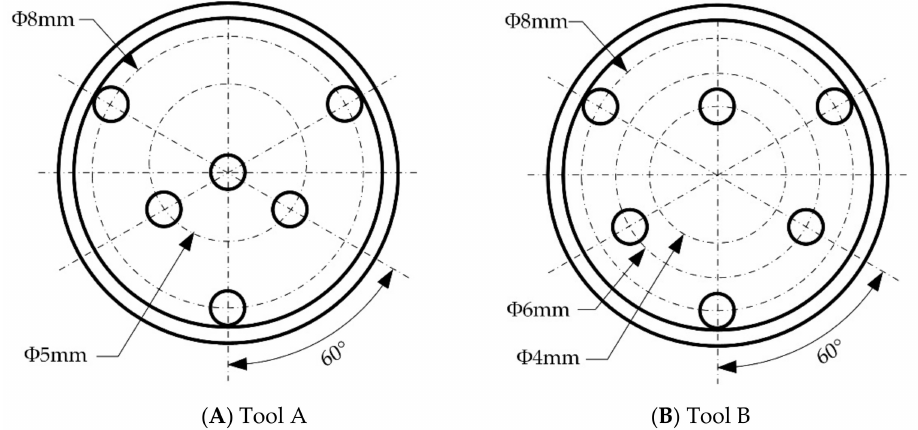
Figure 1. Design of the liquid outlet form of different cathode tools. ( A ) Tool A electrolyte outlet layout; ( B ) Tool B electrolyte outlet layout.